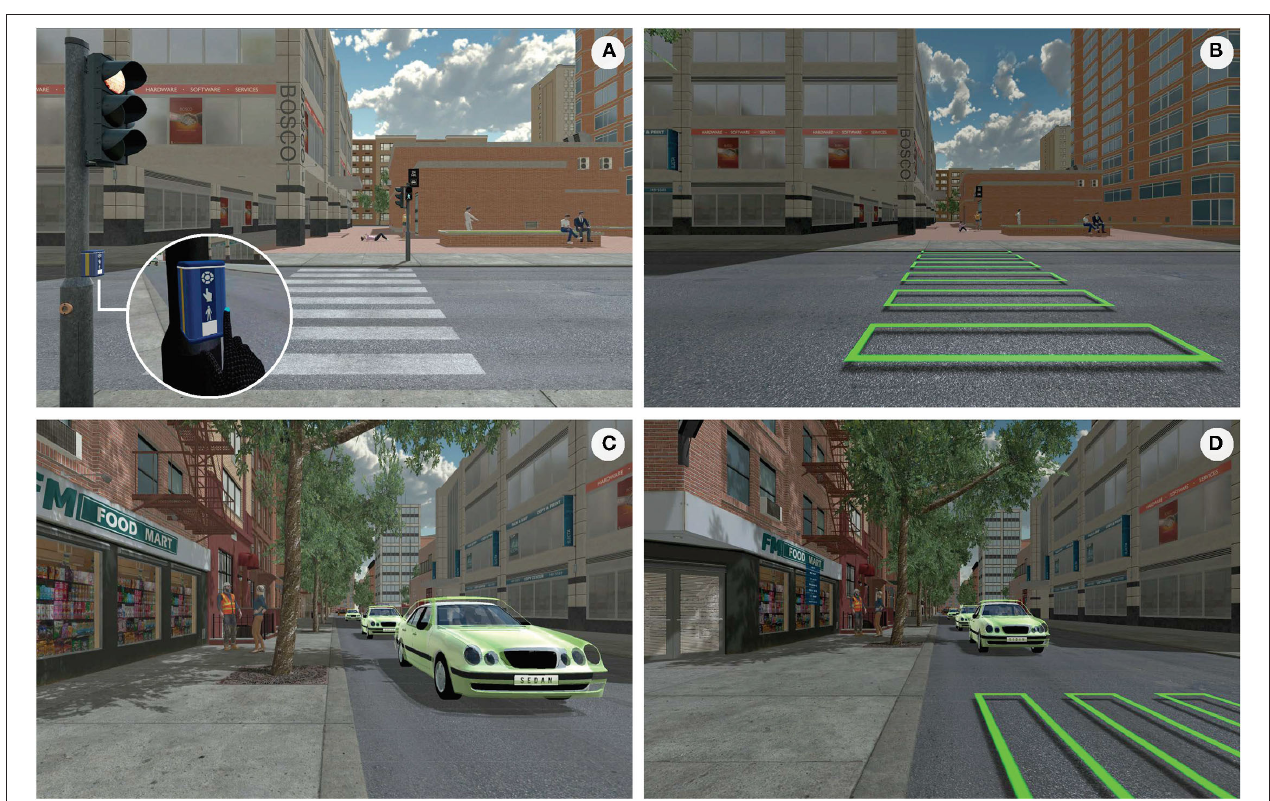
FIGURE 2 | Simulation environment and interfaces included in the evaluation: (A) Pedestrian push button; (B) AR crosswalk; (C) AR overlay; (D)